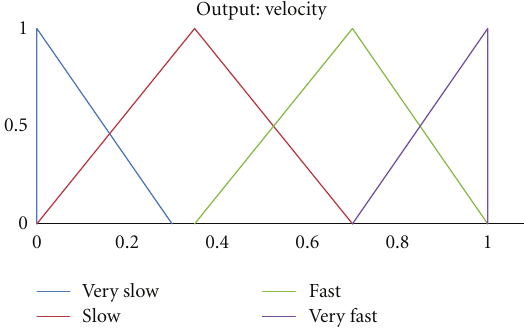
Figure 8: Output: percentage of maximum velocity.